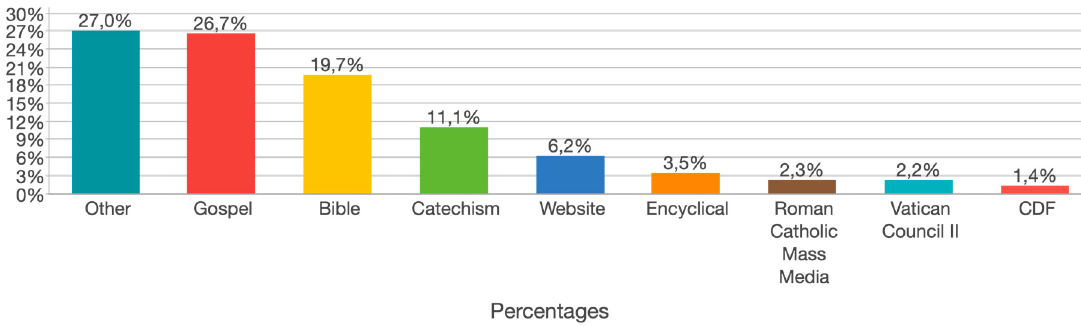
Figure 2. Religious authority—texts.